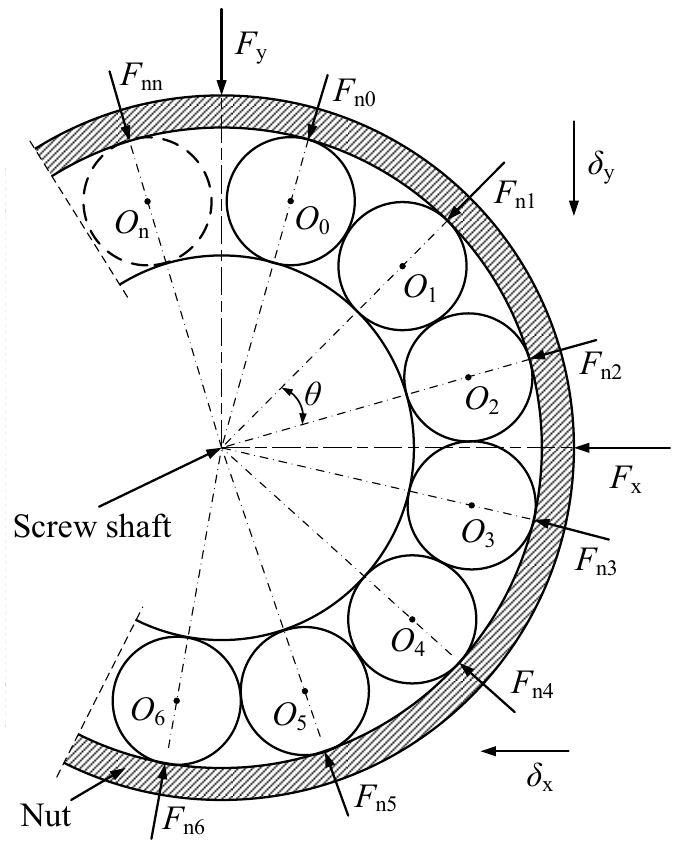
Figure 6. F n i direction of each ball in the ball nut.